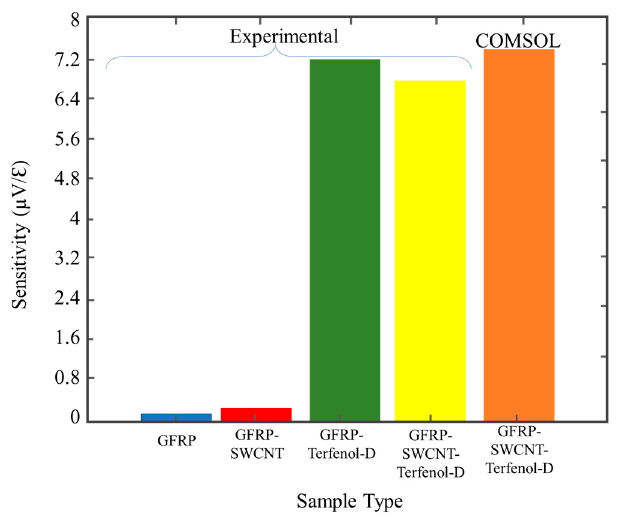
Figure 16. Sensor sensitivity variation for different samples in both experiment and COMSOL data.